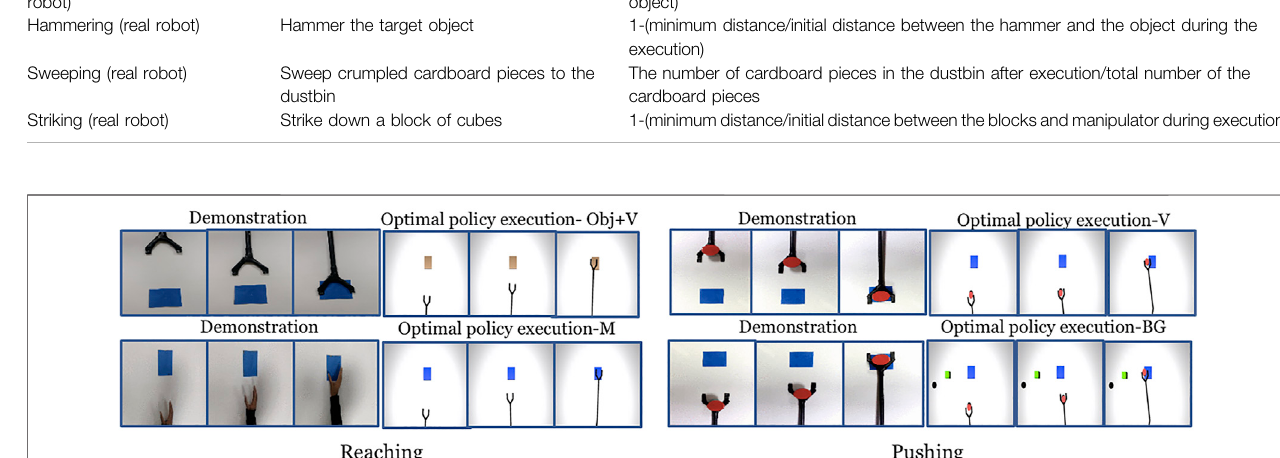
FIGURE 4 | Snapshots of the demonstration and the execution of corresponding learned policies in the simulation experiment for selected domain shifts. (Results shown for action vectors extracted from pool5 layer of NN:UCF101 model).